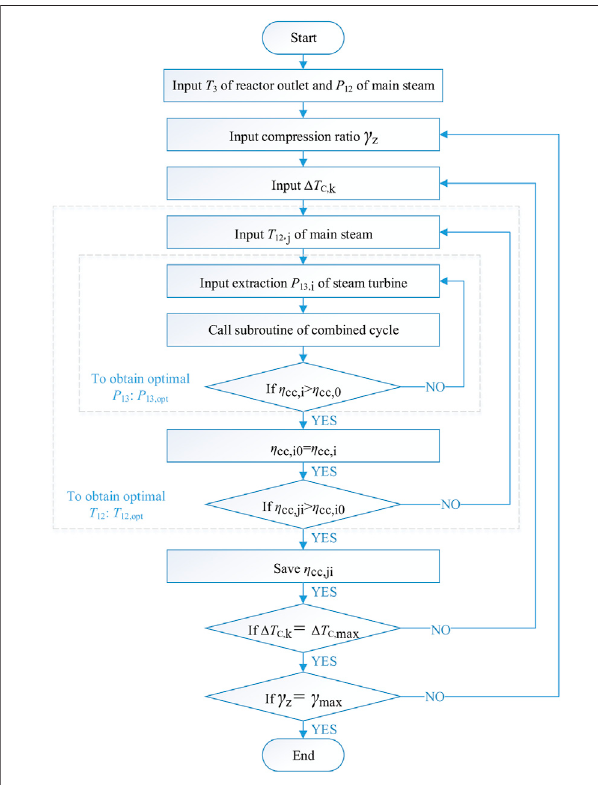
FIGURE 3 | Calculation and analysis methods.